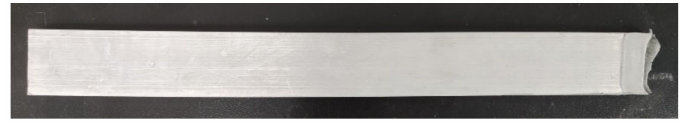
Figure 1. Al-Mg-Li alloy extrusion